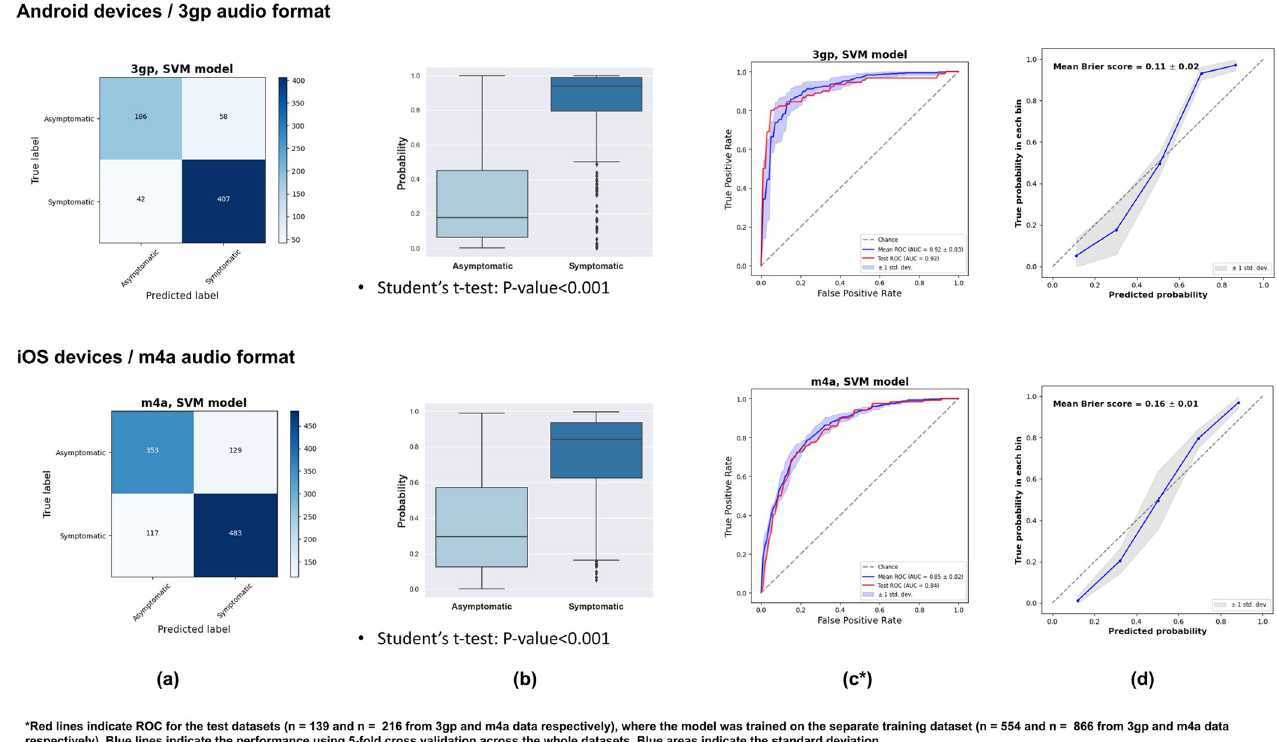
Fig 2. Vocal biomarker distribution in people with and without symptoms—Confusion Matrix (a), Boxplot (b), AUC (c), Calibration curve (d).